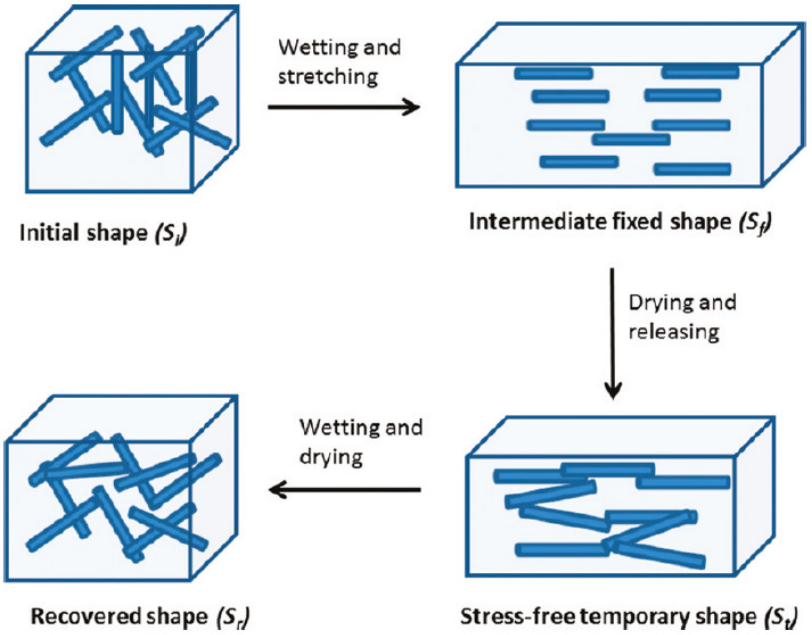
Figure 7. Schematic representation of the shape-memory materials explored here, which rely on switching the interactions between cellulose nanowhiskers within a polymer matrix upon addition and removal of water. Reproduced with permission from [175]. Copyright 2011 American Chemical